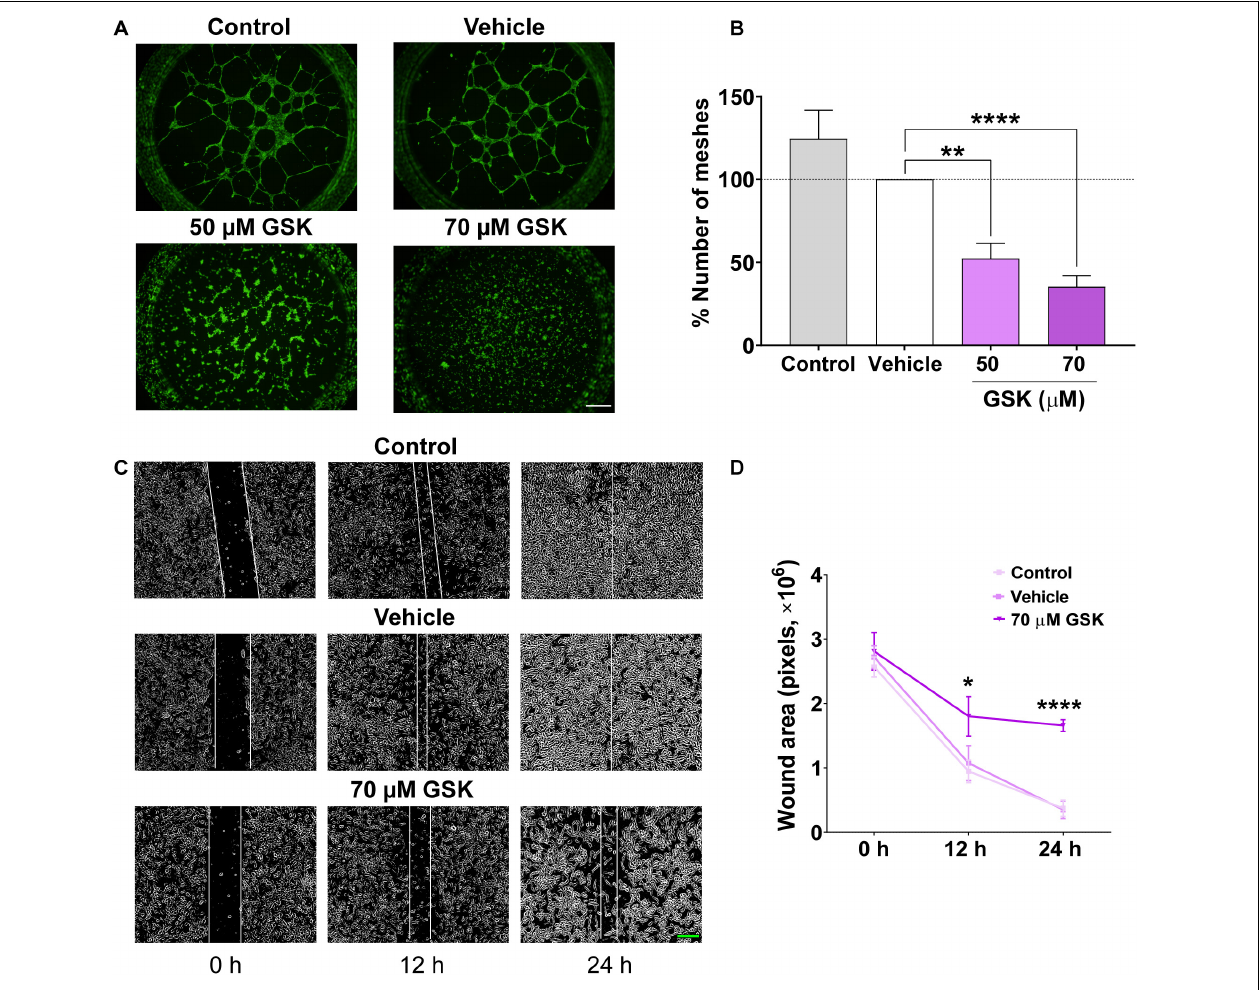
FIGURE 2 | GSK-7975A decreases HUVEC tube formation and migration. (A) Fluorescence images ( × 4 objective; scale bar = 500 µ m) are from HUVECs (control, vehicle, 50 and 70 µ M of GSK) incubated with Calcein-AM and seeded on Matrigel. (B) Bar graph shows normalized means of the percentage of meshes to the number in HUVECs treated with vehicle (gray). Bars are for untreated HUVECs, for HUVECs treated with vehicle (white), and with 50 or 70 µ M of GSK ( n = 6). (C) Phase-contrast imaging ( × 10 objective; green scale bar = 200 µ m) of the HUVEC wound healing assay. HUVEC was cultured in the endothelial cell culture medium (EGM-2) enriched with growth factors. Images are from control cells and for those treated with vehicle and 70 µ M of GSK, taken at 0, 12, and 24 h. (D) Graph shows summary data of the evolution of the wound area ( n = 6 per group). Values are presented as the means ± S.E.M. (*), (**), and (****) indicate significance with p < 0.05, p < 0.01, and p < 0.0001,